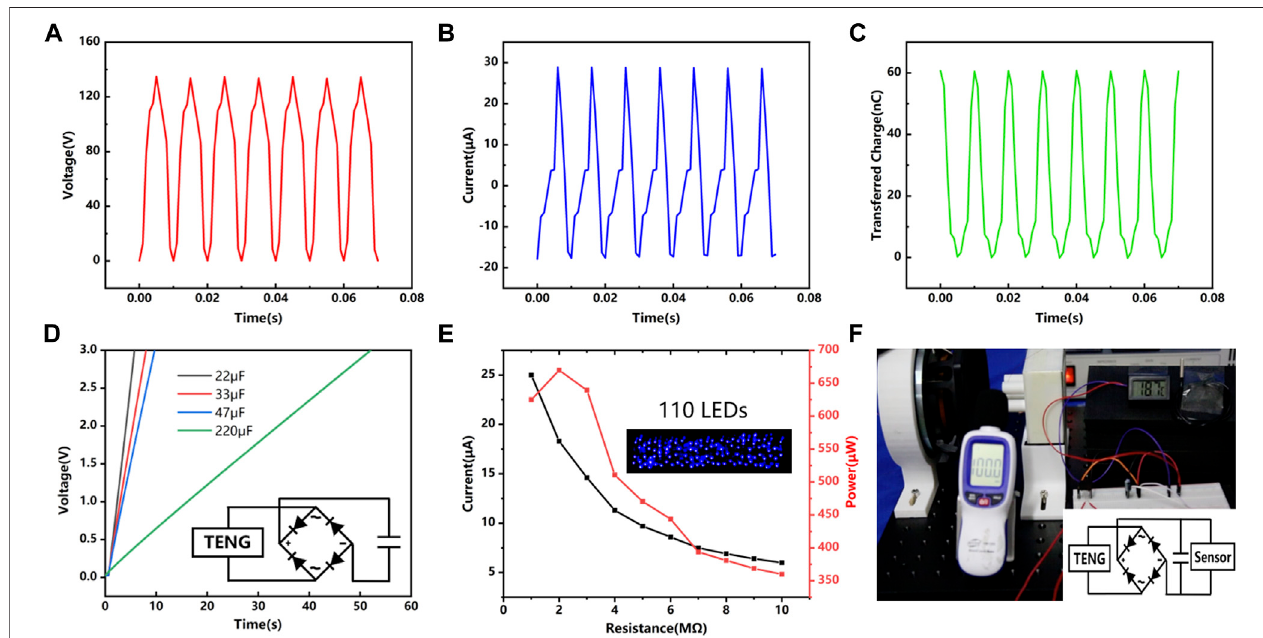
FIGURE5 | (A) The V oc (B) I sc , and (C) Q sc of MH-TENG driven bysound waves of100 Hz and 106 dB (D) Charging performance ofdifferentcapacitors powered by MH-TENG (E) Resistance matching test experiment of MH-TENG (F) Demonstration of MH-TENG supplying power to an electronic